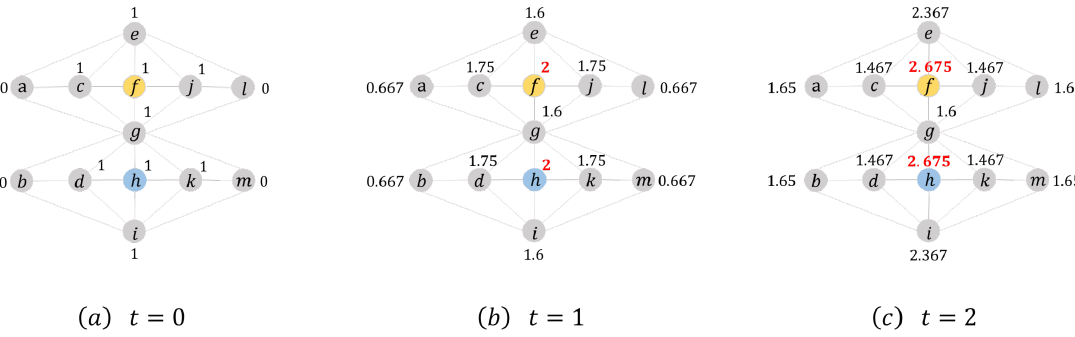
Figure 2. An example of multiple sources localization. ( a – c ) represent the potential concentration label of the network at different iteration